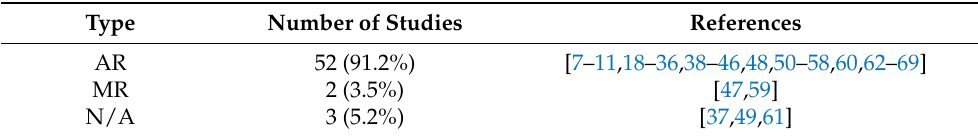
Table 8. Number of studies based on data visualization method and their percentage. Type